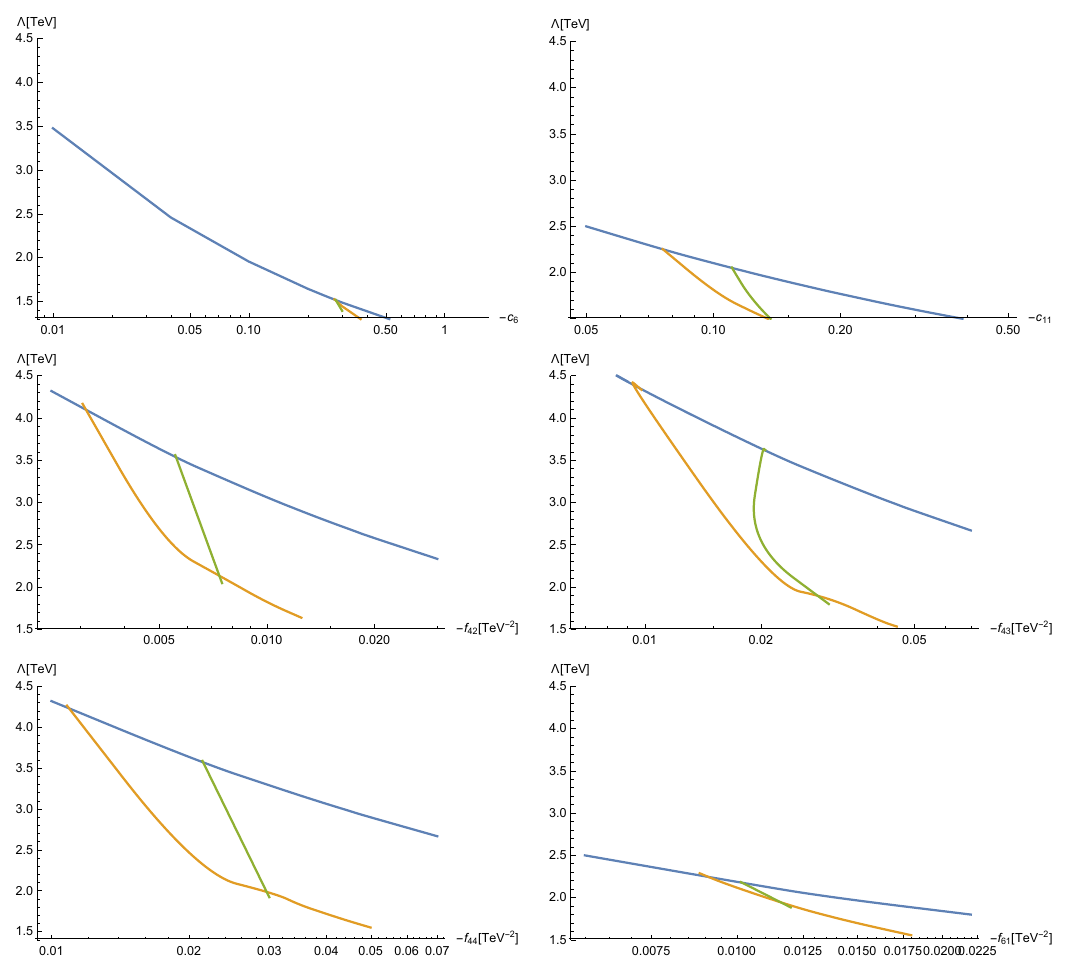
Figure 4 . Same description and operators as in (cid:12)gure 2. Negative values for c i and f i are